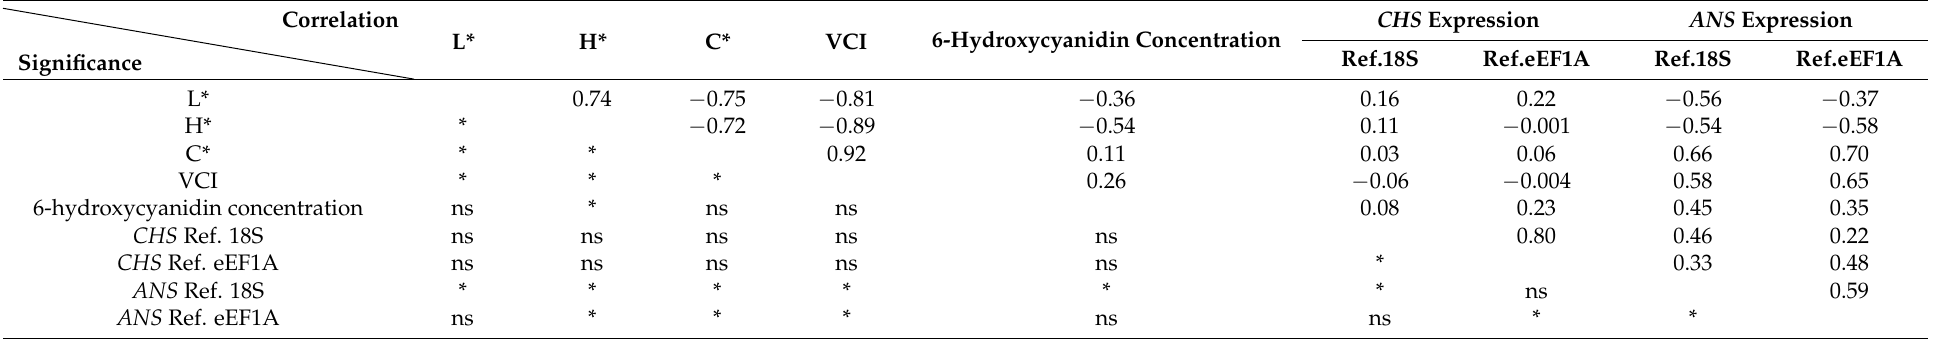
Table 3. Correlations between L*, C*, h*, VCI, 6-hydroxycyanidin relative concentration and CHS and ANS gene expression, observed in the principal component analysis for the five A. pallida accessions (Significance \